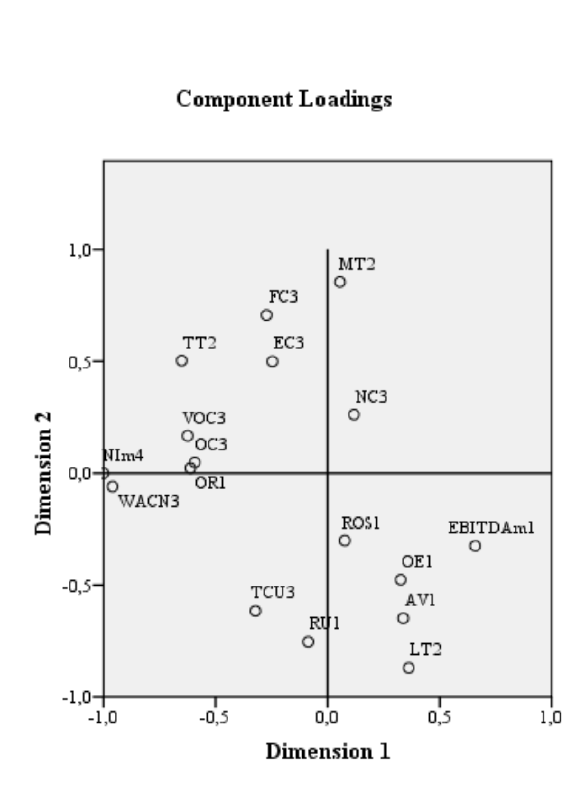
Figure 2. “Component Loadings 2006